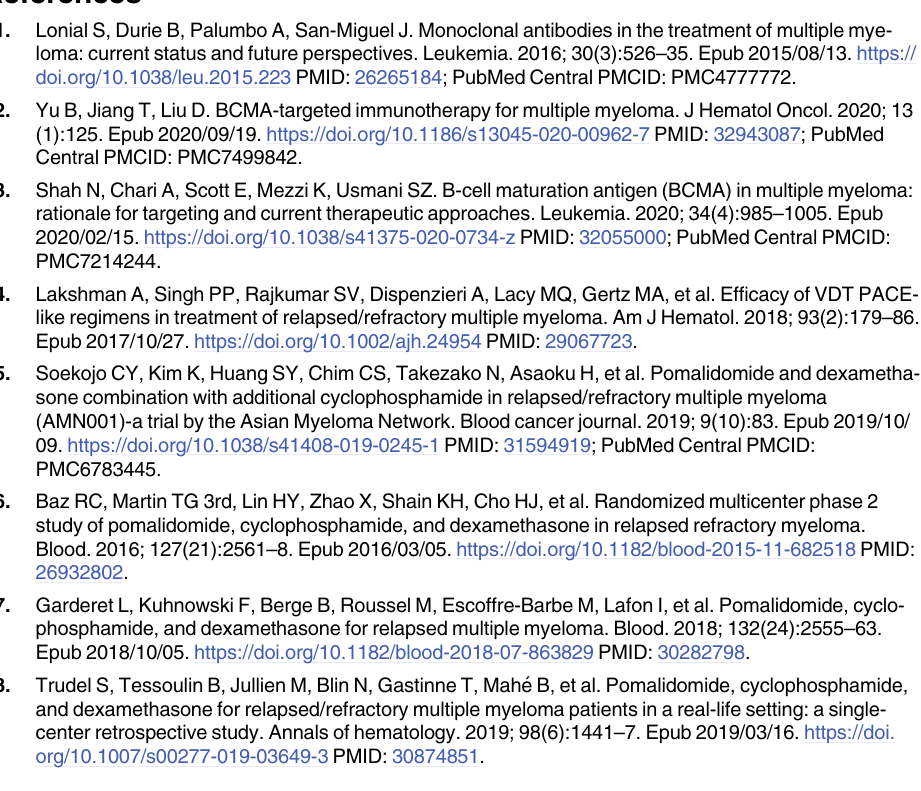
S1 Fig. CONSORT diagram. S2 Fig. PFS and OS according to pomalidomide response. S3 Fig. Subsequent treatment after pomalidomide-based